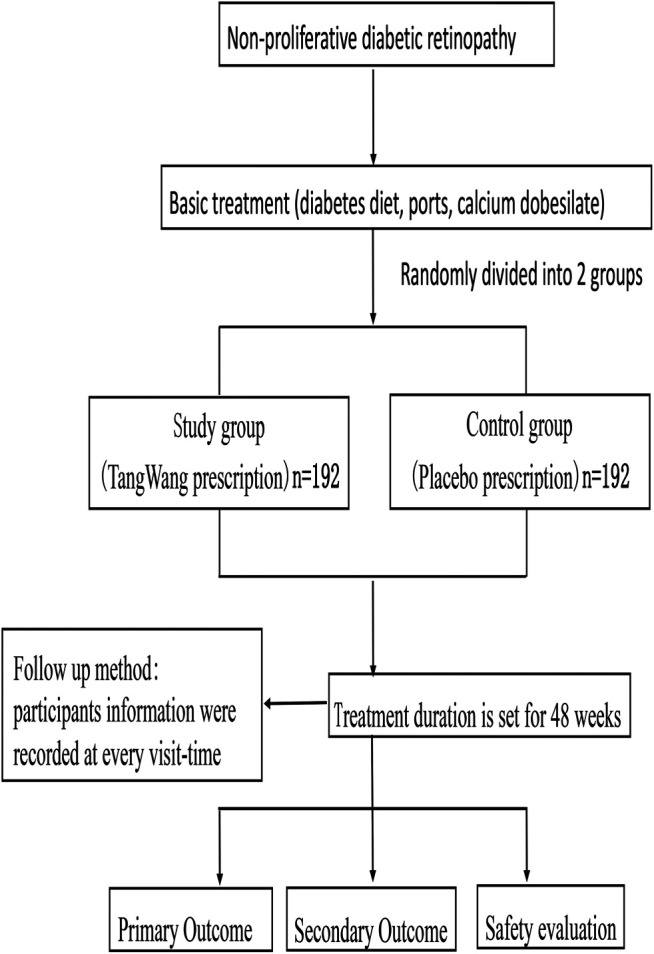
The trial schematic flow.